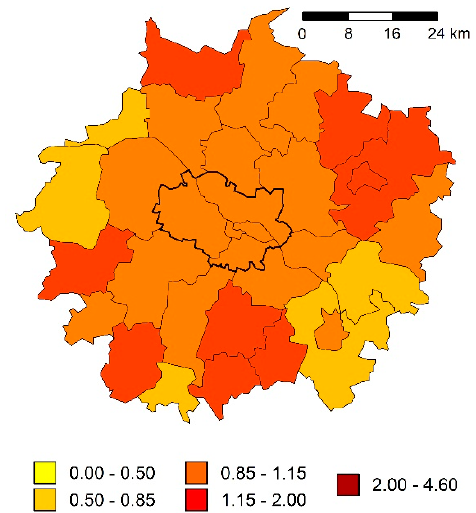
Figure 9. Concentration of low-technology industrial entities in the housing estate of Wroc ł aw in 2016 (sourced by authors).